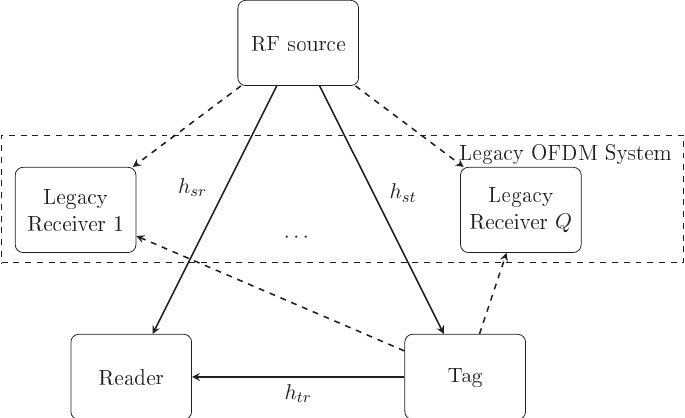
Figure 1. A communication system utilizing the AmBC over OFDM carriers. The AmBC system consists of three main components: RF source (e.g., TV tower), ambient backscatter transmitter (e.g., AmBC tag), and ambient backscattter receiver (e.g., reader), while the legacy OFDM system consists of several legacy receivers (e.g., mobile